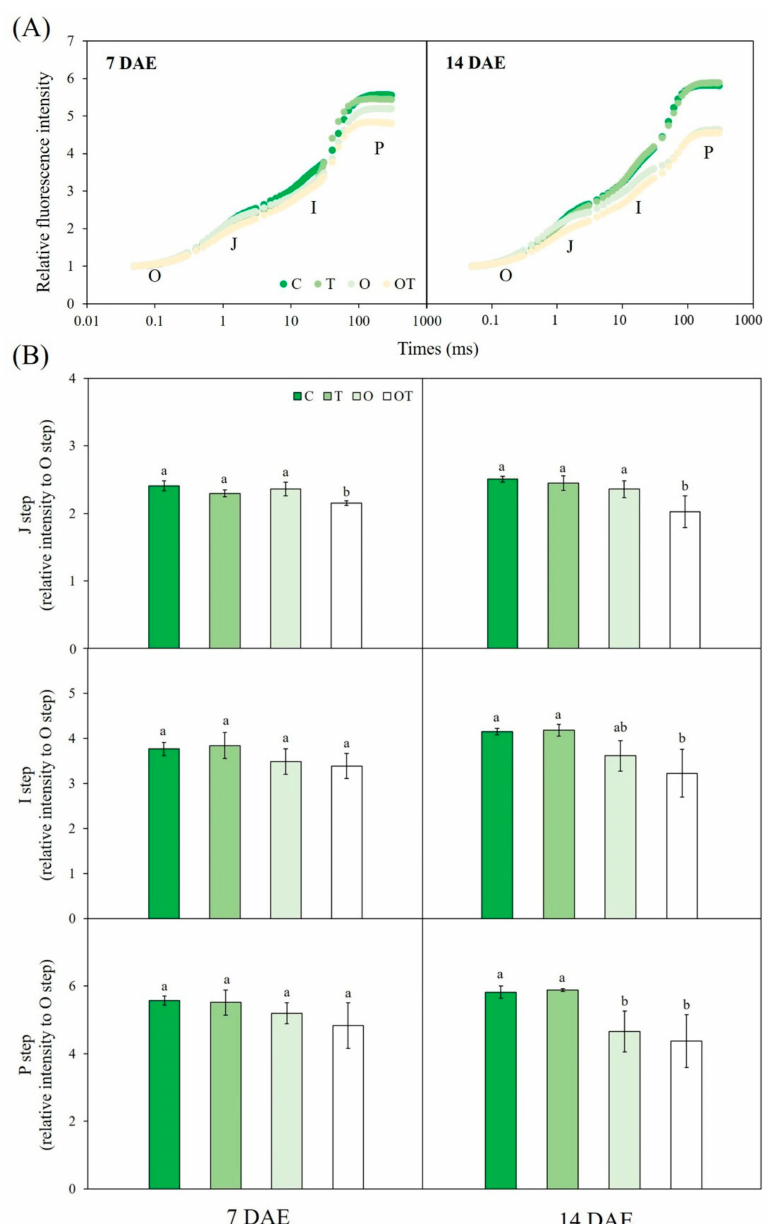
Figure 5. ( A ) Chlorophyll a fluorescence OJIP transient curves and ( B ) J-, I-, and P-steps derived from chlorophyll a fluorescence OJIP transient curves of Brassica juncea L. under different ambient and supraoptimal temperatures and O 3 concentrations at 7 and 14 DAE. The J- (intensity at 2 ms), I- (intensity at 30 ms), and P (maximum intensity when all PS II reaction centers (RCs) are closed) steps in the figure indicate fluorescence intensity at these points relative to that at the O-step (when all PS II RCs are open). Data are plotted as mean ± SD ( n = 5). Different letters indicate significant differences among treatments at p < 0.05 according to Tukey’s honestly significant difference test. C: ambient O 3 + optimal temperature; T: ambient O 3 + supraoptimal temperature; O: elevated O 3 + optimal temperature; OT: elevated O 3 + supraoptimal temperature; DAE: days after the beginning of